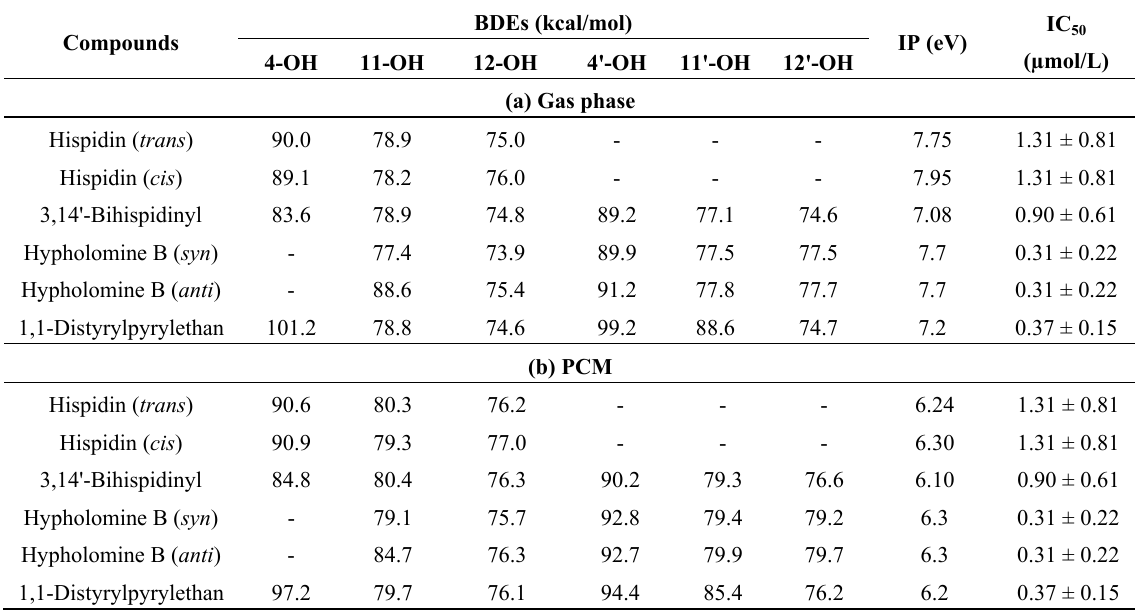
Table 2. BDEs and IPs of hispidin oligomers calculated at B3P86/6-31+G(d,p) level. Compounds